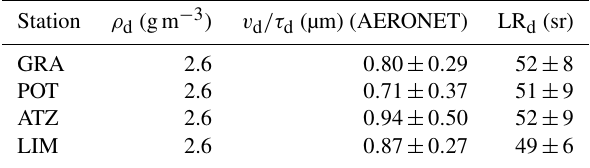
Table 2. Assumed ( ρ d ) and computed parameters (v d /τ d , LR d ) used for the estimation of the height-resolved mass concentration (in kgm − 3 ) of dust particles. The ratio v d /τ d is derived from AERONET sun–sky photometer measurements within the period 2014–2017 at Granada, Potenza, Athens and Limassol. The LR d is calculated from the available corresponding lidar measurements per